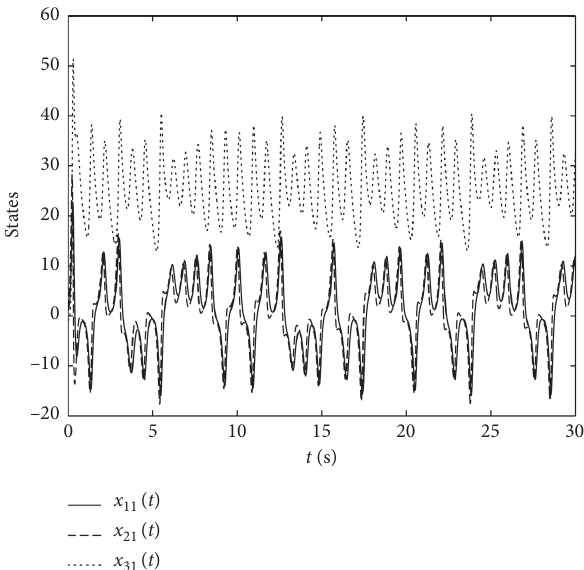
Figure 2: The state of subsystem 1 in nonlinear fractional order interconnected systems.